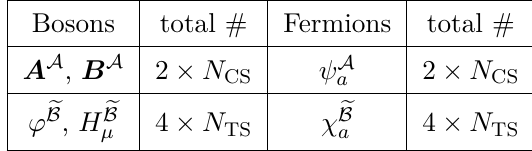
Table 3 . The summary of on-shell component fields in the CS+TS+nTS-A